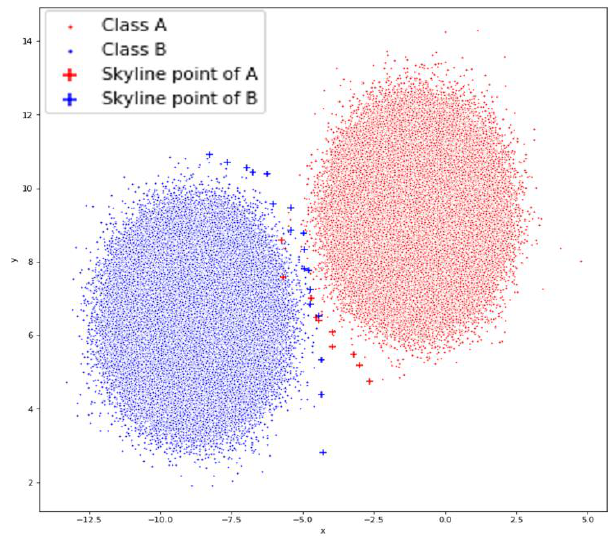
Figure 9. Single skyline on the synthetic Dataset I.